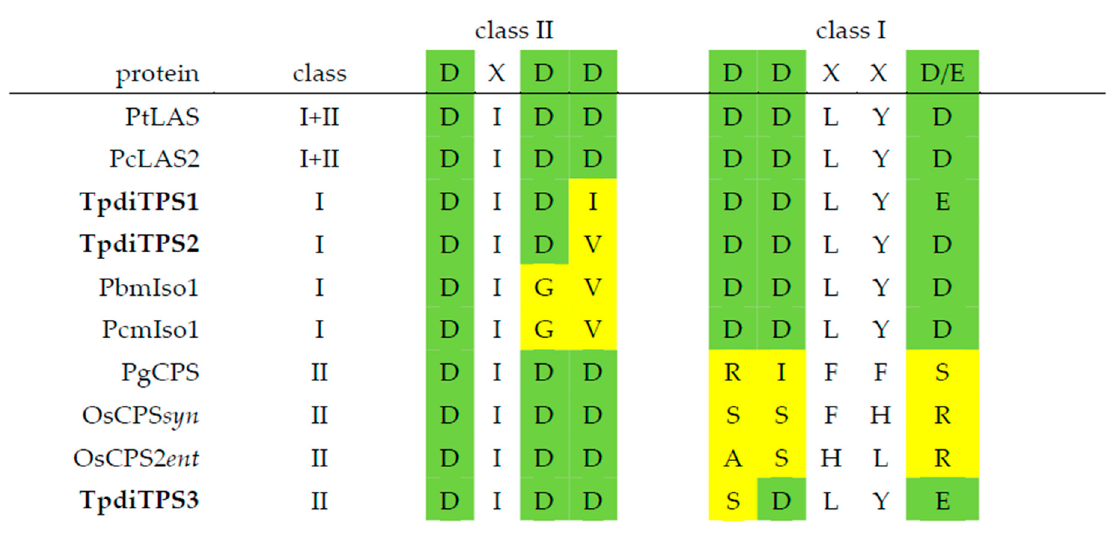
Figure 3. Putative catalytic motifs in TpdiTPS1 and 2 match monofunctional class I proteins